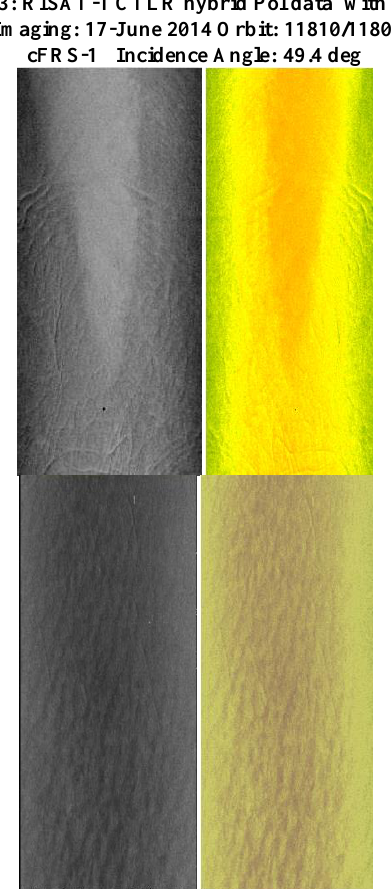
Figure 4: Look-alike signatures (T to B) 1a ,1b- Conformity Coefficient 2a, 2b- Correlation